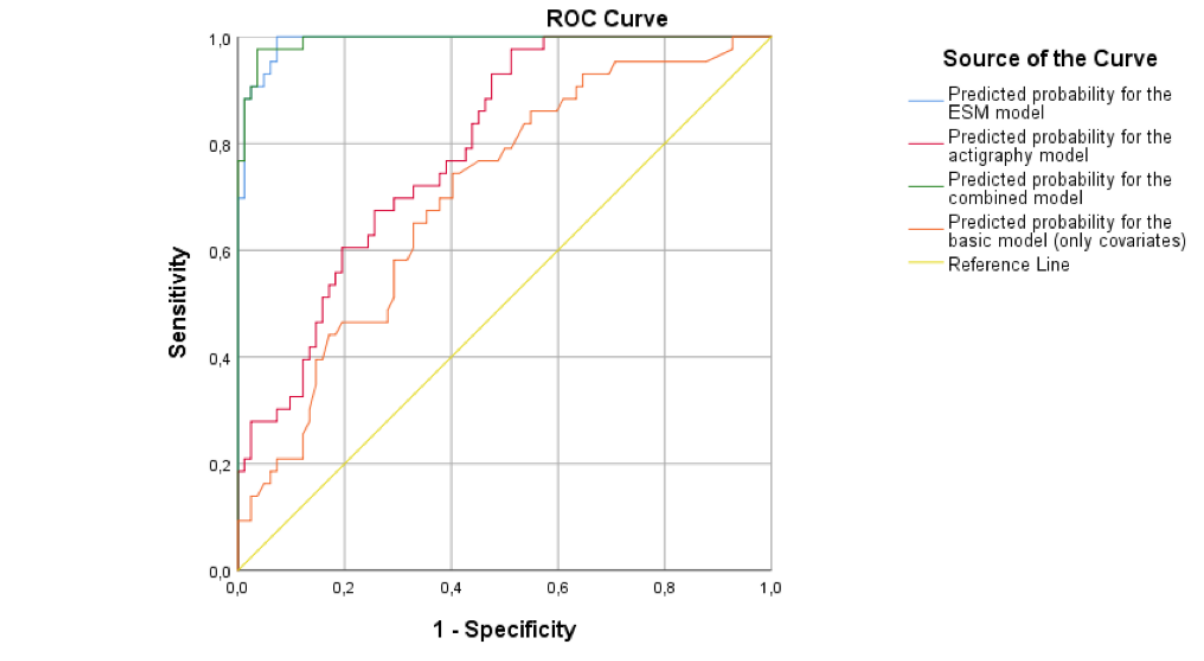
Figure 2. The receiver operating characteristic (ROC) curves of the basic model, the experience sampling method (ESM) model, the actigraphy model, and the combined-domains model in the development data set (the Netherlands Study of Depression and